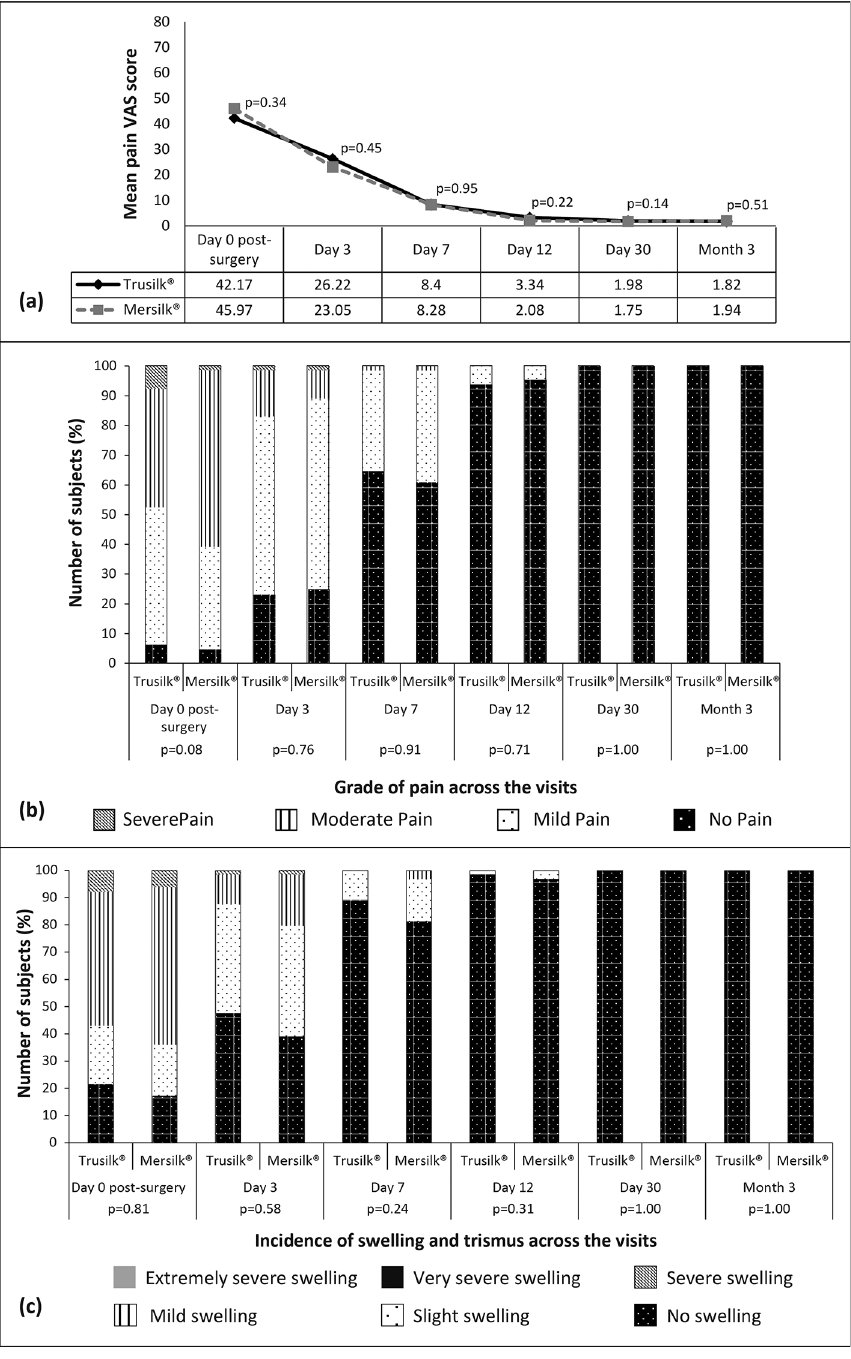
Figure2.Pain(a&b),swellingandtrismus(c)inTrusilk ® (n=65)andMersilk ® (n=64)group. VAS:VisualAnalogue